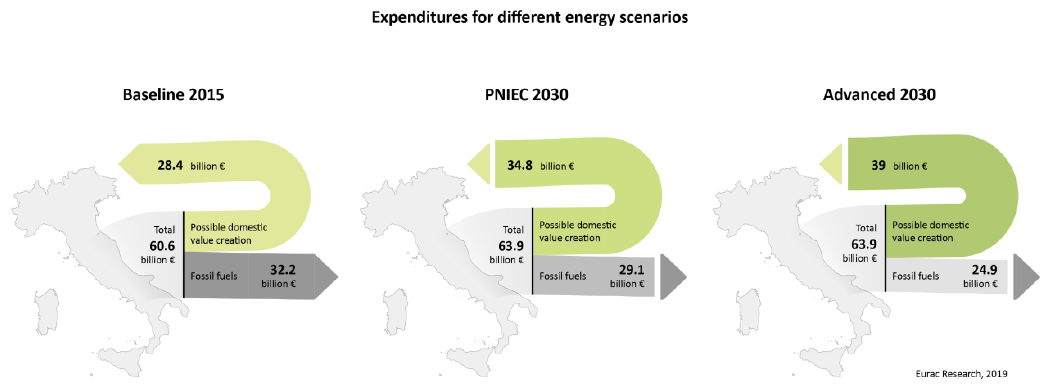
Figure 13. Subdivision of annual costs in the scenarios Baseline 2015, PNIEC 2030 and Advanced 2030.